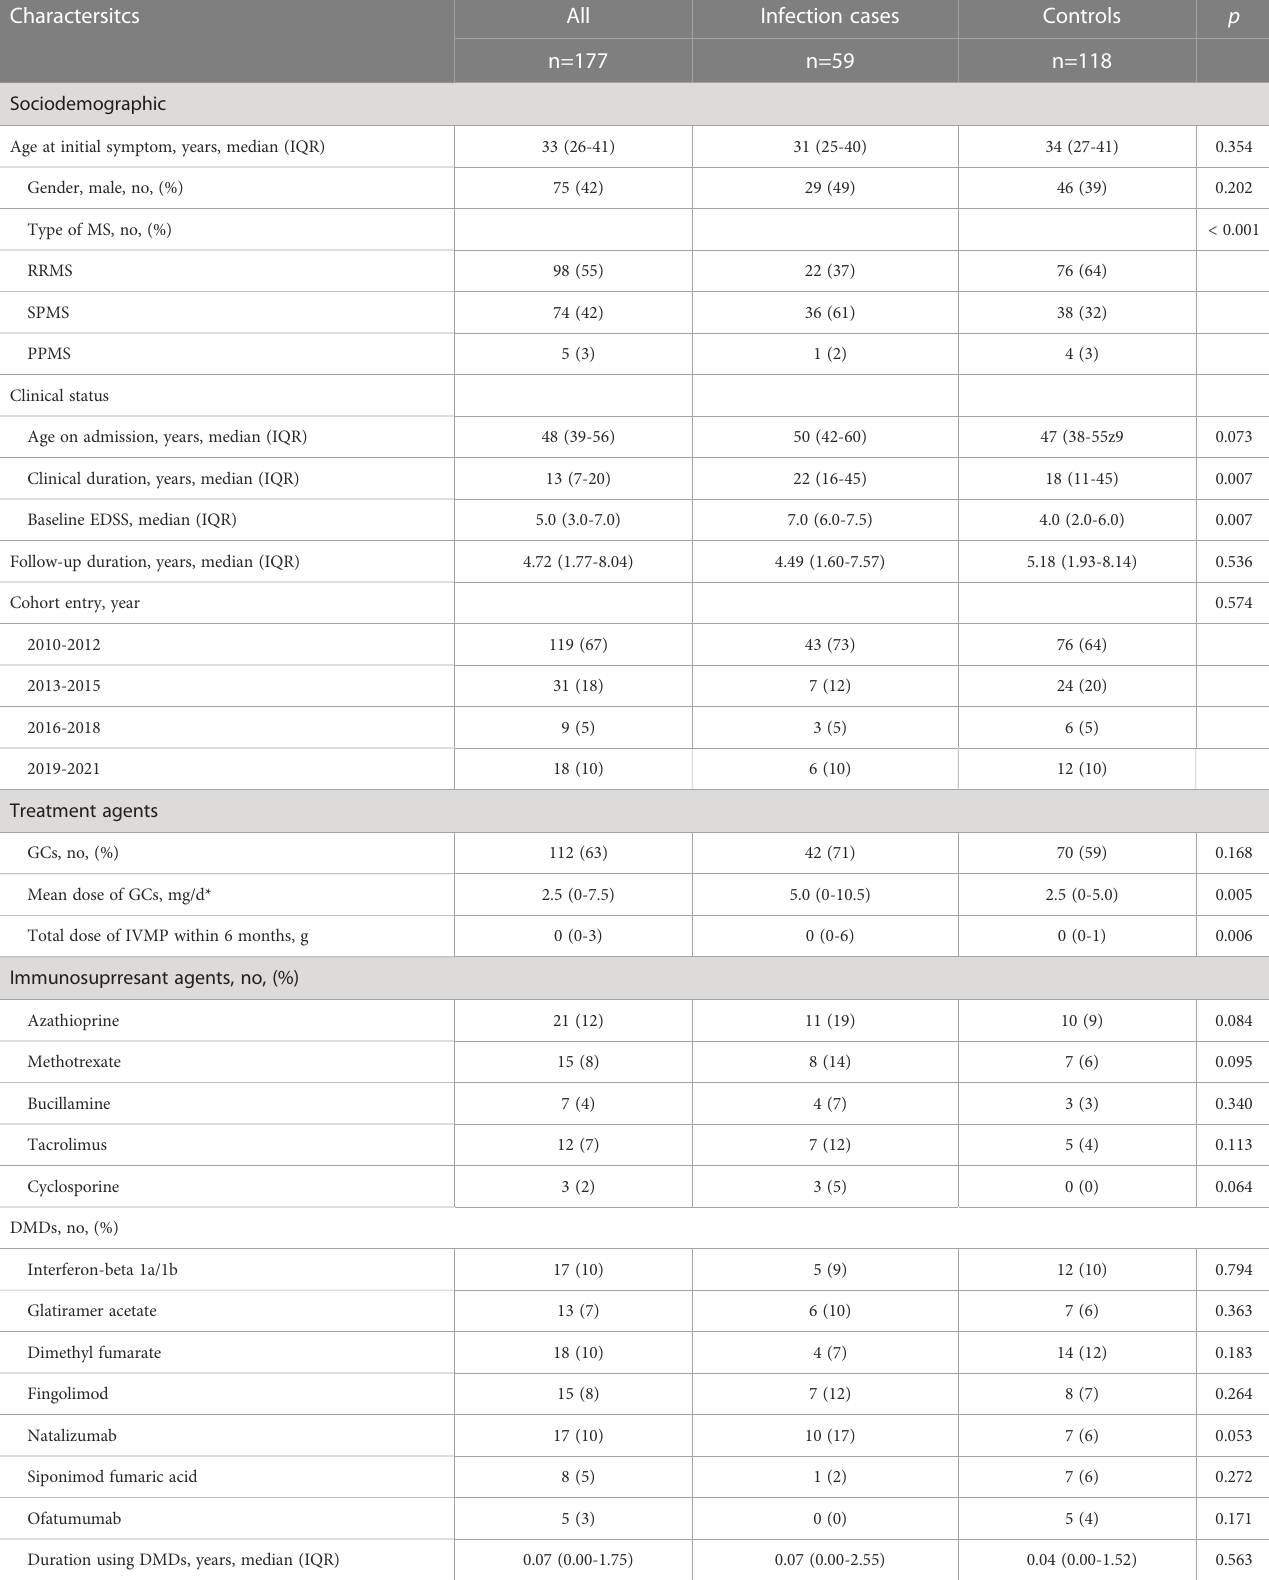
TABLE 2 Clinical variables between infection cases and